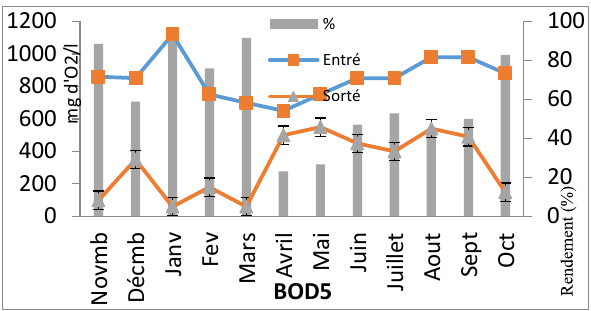
Figure 6. Change in BOD 5 values at the entrance and exit of the